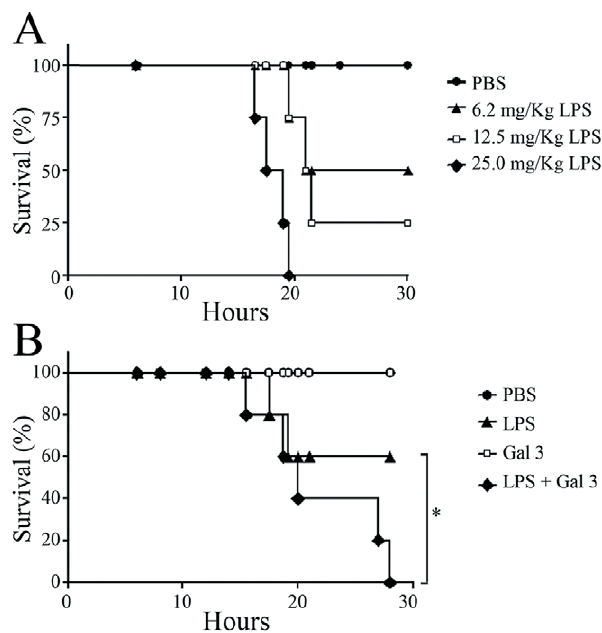
Figure 7. Gal 3/LPS interaction decreases mice resistance to the lethality of LPS. A : Groups of 5 Balb/C mice were challenged with PBS, 6.2, 12.5 or 25 mg/kg of E. coli LPS by intraperitoneal (ip) injection. B : Mice (5 per group) were challenged with 500 m l of PBS, Gal 3 (40 m M), 6.2 mg/kg LPS or with a mixture of LPS (6.2 mg/kg) and Gal 3 (40 m M) preincubated for 15 min. The mortality rate was monitored regularly and represented as percentage of survival. *p , 0.05.